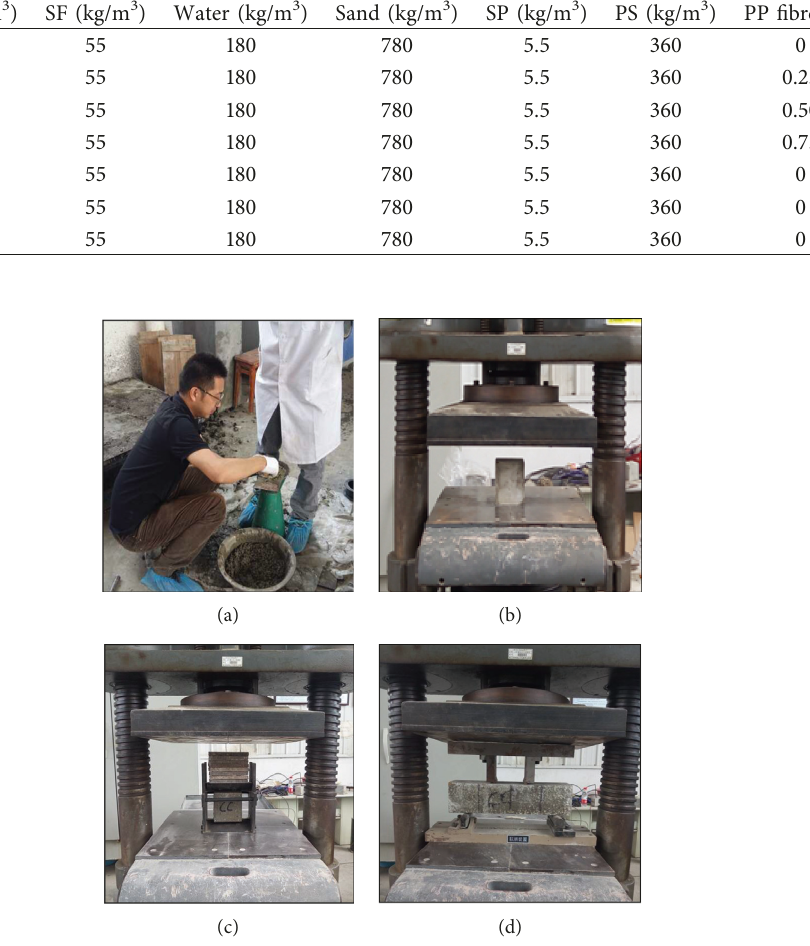
Figure 2: (a) Slump test, (b) compressive test, (c) splitting tensile test, and (d) flexural strength